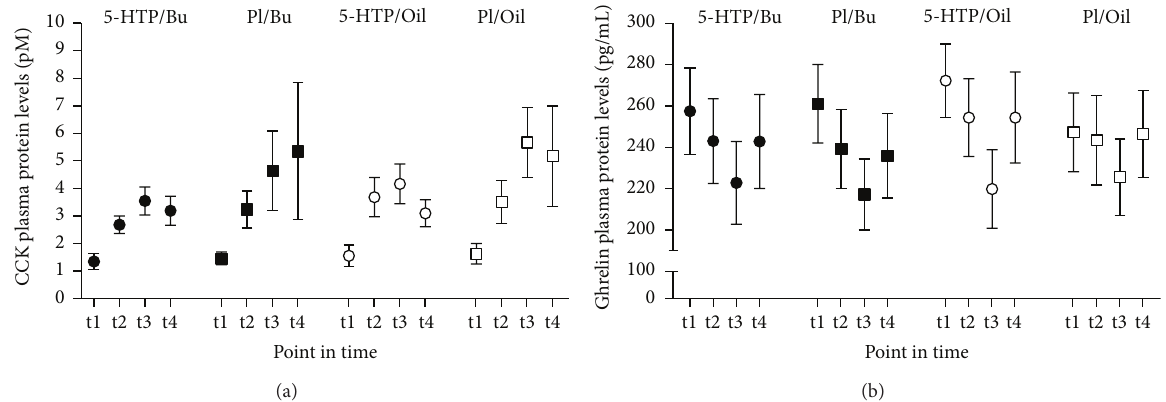
Figure 3: Cholecystokinin and ghrelin. The influence of 5-hydroxytryptophan (5-HTP) and fatty acid ingestion on cholecystokinin (CCK (a)) and ghrelin (b) plasma concentrations. Participants received a capsule with either 5-HTP or placebo (Pl). They also ingested a standard breakfast supplemented with 100 𝜇 L 13 C octanoid acid and either butter (Bu) or olive oil (Oil). Plasma samples were taken during fasting (t1) and after 5-HTP or placebo intake after 2.5 hrs (t2), 4hrs (t3), and 5.5 hrs (t4). In (a) and (b) the actual plasma concentrations of CCK and ghrelin protein are presented as means ± SE. Statistics: CCK; time: F = 6.136; 𝑃 < 0.05 . Ghrelin; fatty acid ∗ 5 -HTP/Pl: F = 9.166; 𝑃 < 0.001 .